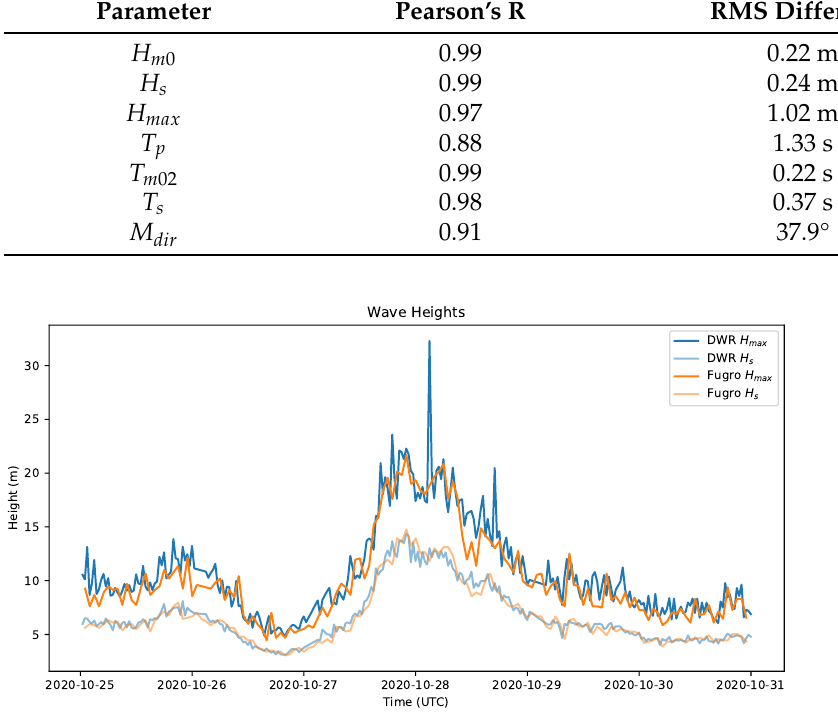
Figure 3. Datawell (DWR) and Fugro Wavesense Significant ( H s ) and Maximum ( H max ) Wave Height during the storm of 25–31 October 2020.